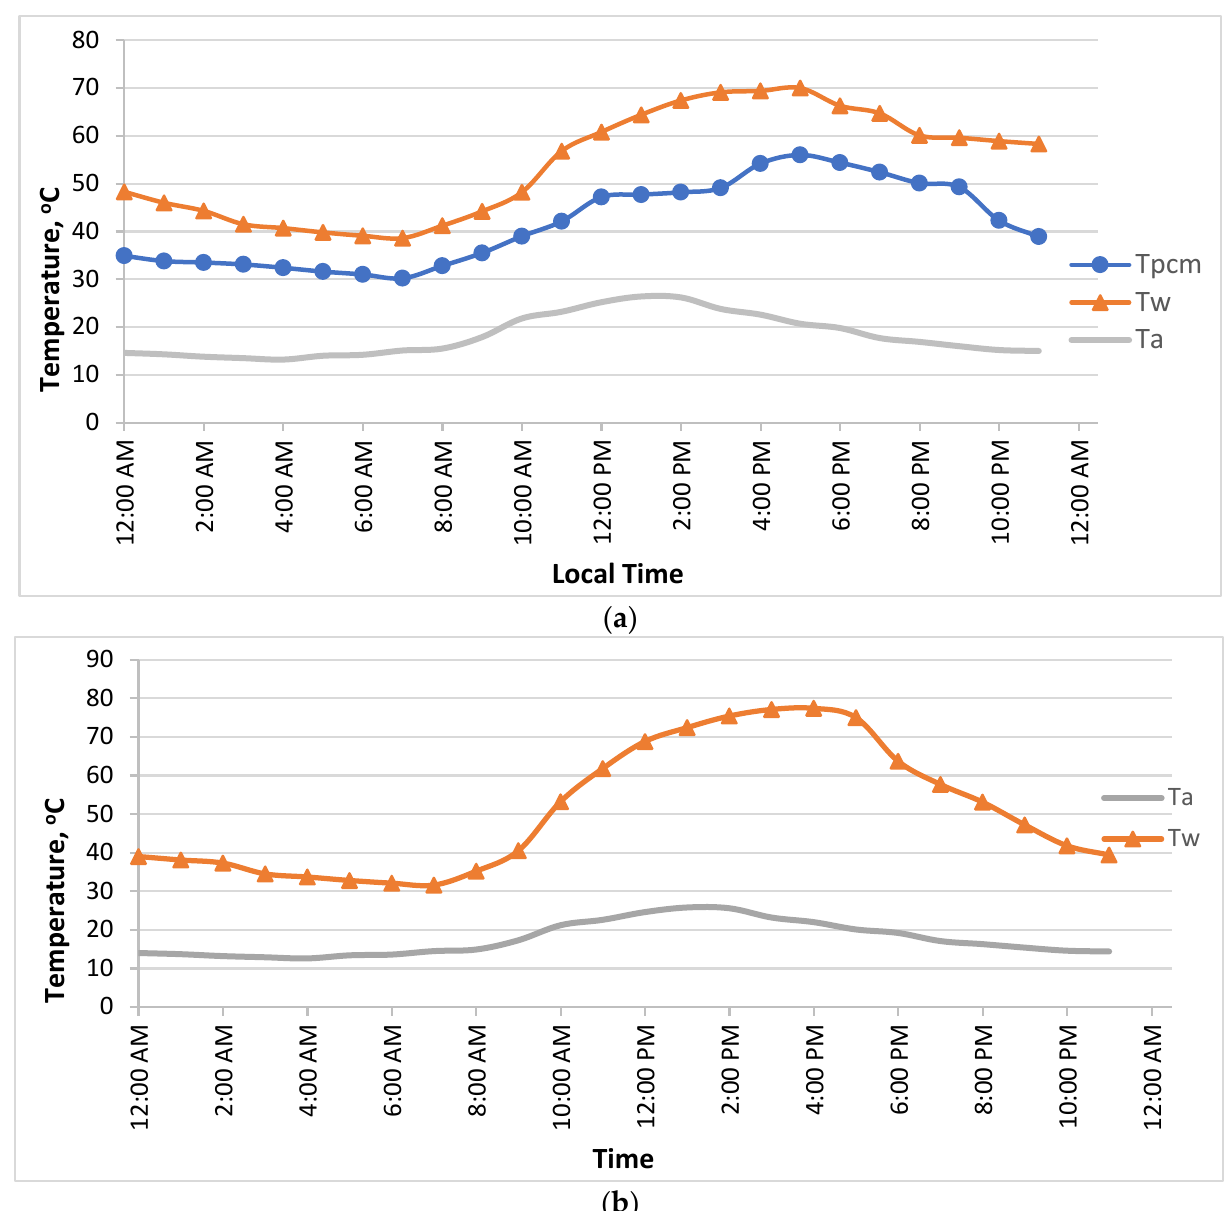
Figure 6. Temperature distribution of the system through March 2022: ( a ) using paraffin as PCM; ( b ) without PCM.